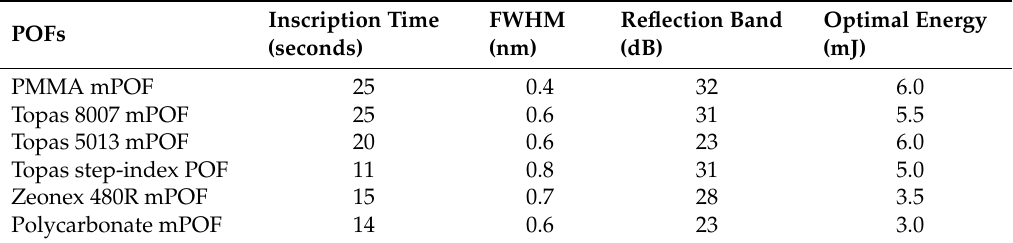
Figure 3. Reflected spectrum of a FBG in a trans-4-stilbenemethanol (TS)-doped, step-index POF, inscribed using a 100 Hz repetition rate and pulse energy of 0.50 ± 0.02 mJ in 0.4 seconds (40 pulses); image adapted from [98]. Table 2. POFBG inscription with pulsed 248 nm KrF laser system [104].